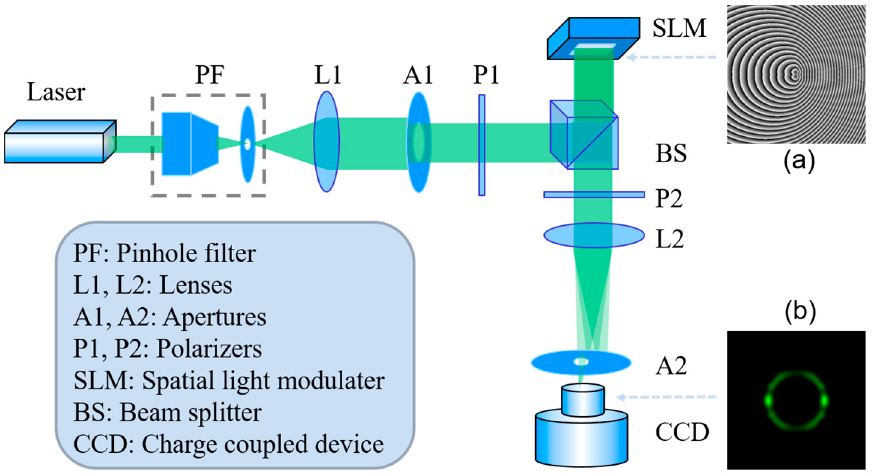
Figure 2. Schematic of the experimental setup. ( a ) phase mask written into the spatial light modulator (SLM) and ( b ) the intensity record by the CCD camera.